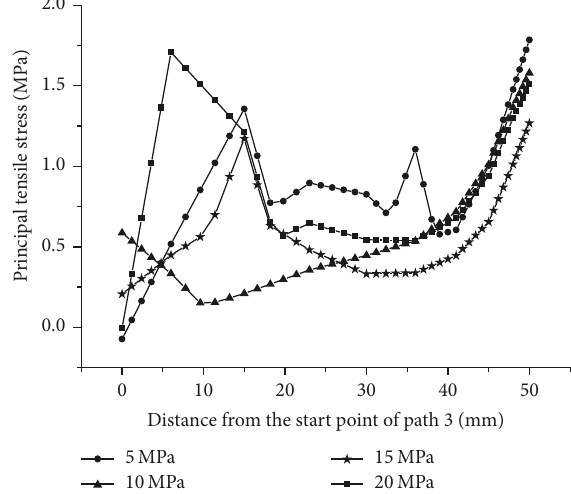
Figure 26: Comparison of the principal tensile stress generated along path 3 from corrosion-induced expansion when the displace- ment resulting from corrosion-induced expansion reaches 0.01